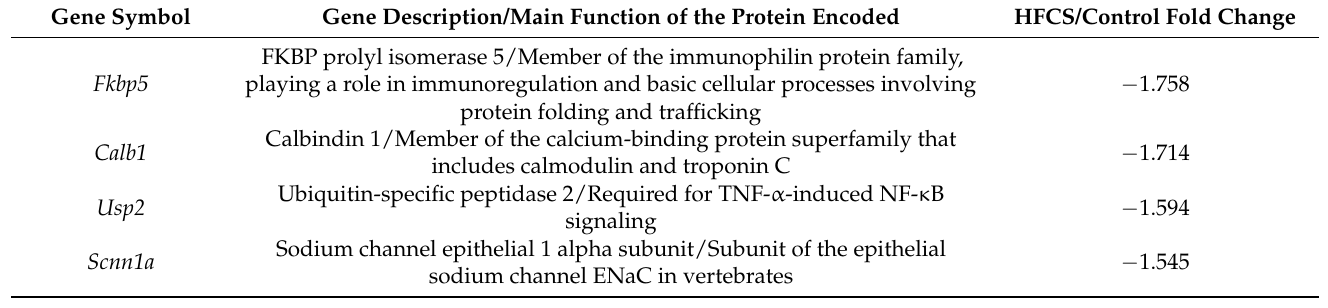
Table 2. Downregulated genes in the high-fructose corn syrup (HFCS) versus control group ( n = 3 each) based on microarray analysis.